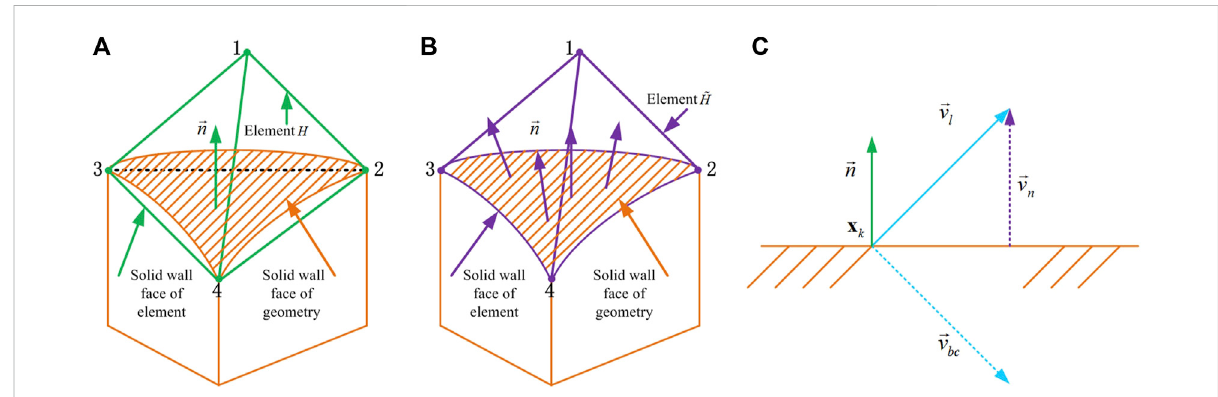
FIGURE 3 Solid wall boundary and geometric description of boundary conditions. (A) is rectilinear boundary element, (B) is curved boundary element, (C) is geometric description of boundary